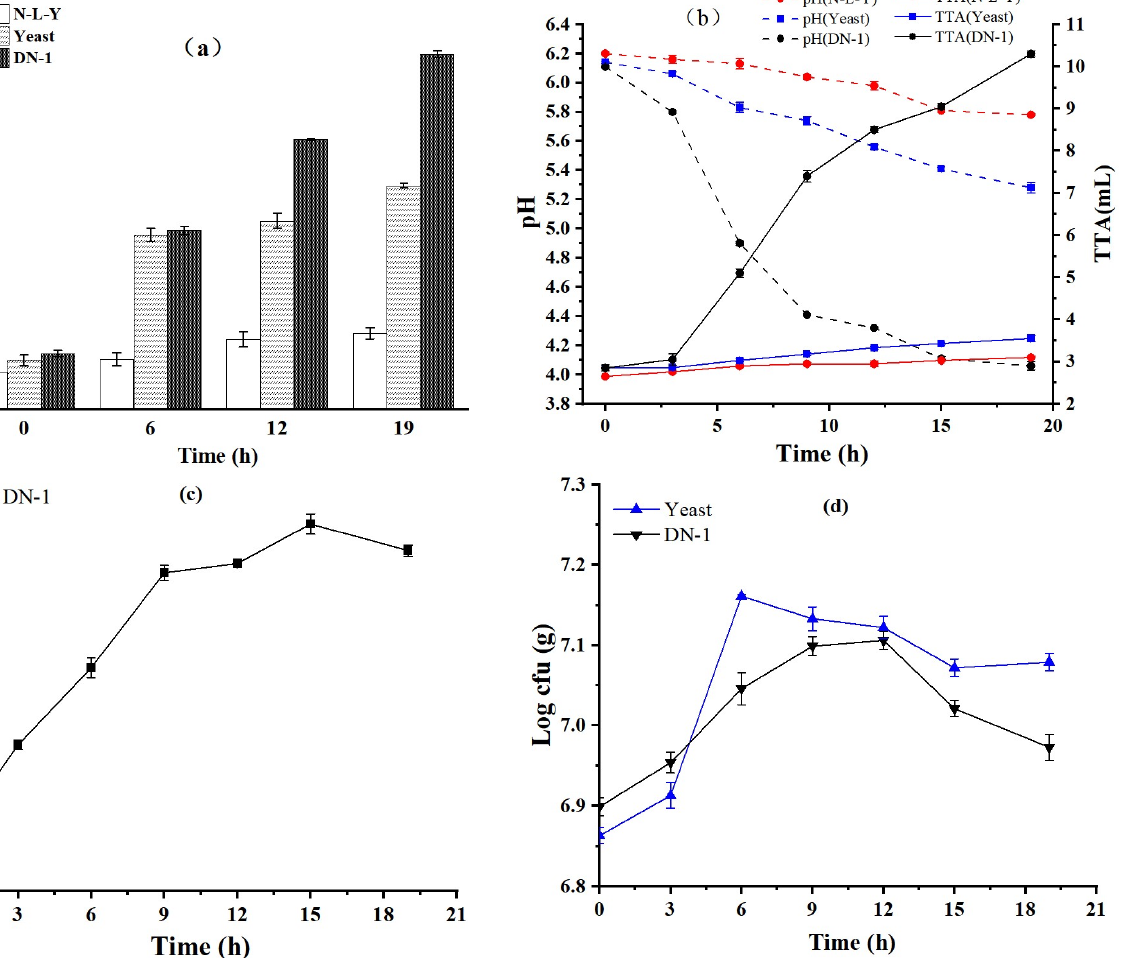
Figure 3. Changes of α -amino nitrogen content ( a ), pH and TTA ( b ), the growth of LAB in DN-1